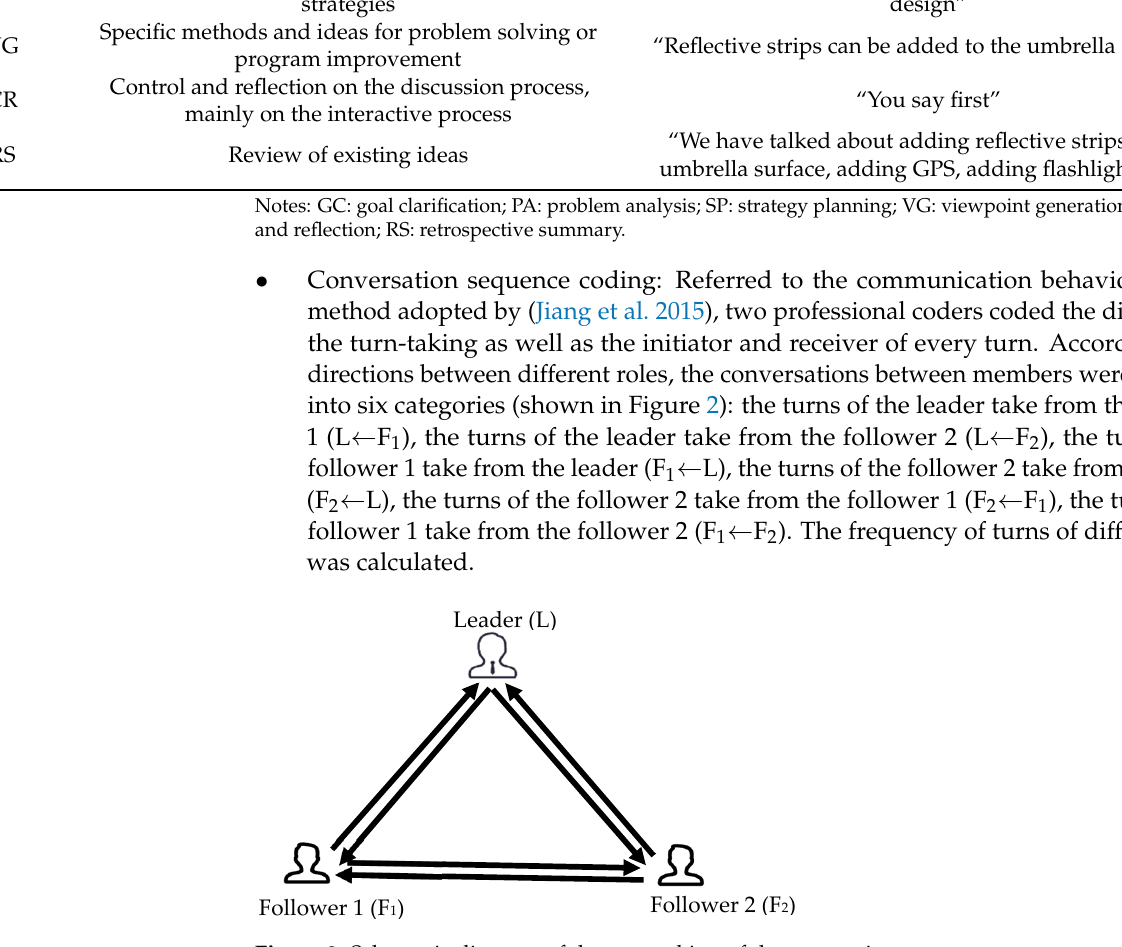
Figure 2. Schematic diagram of the turn-taking of the conversion.